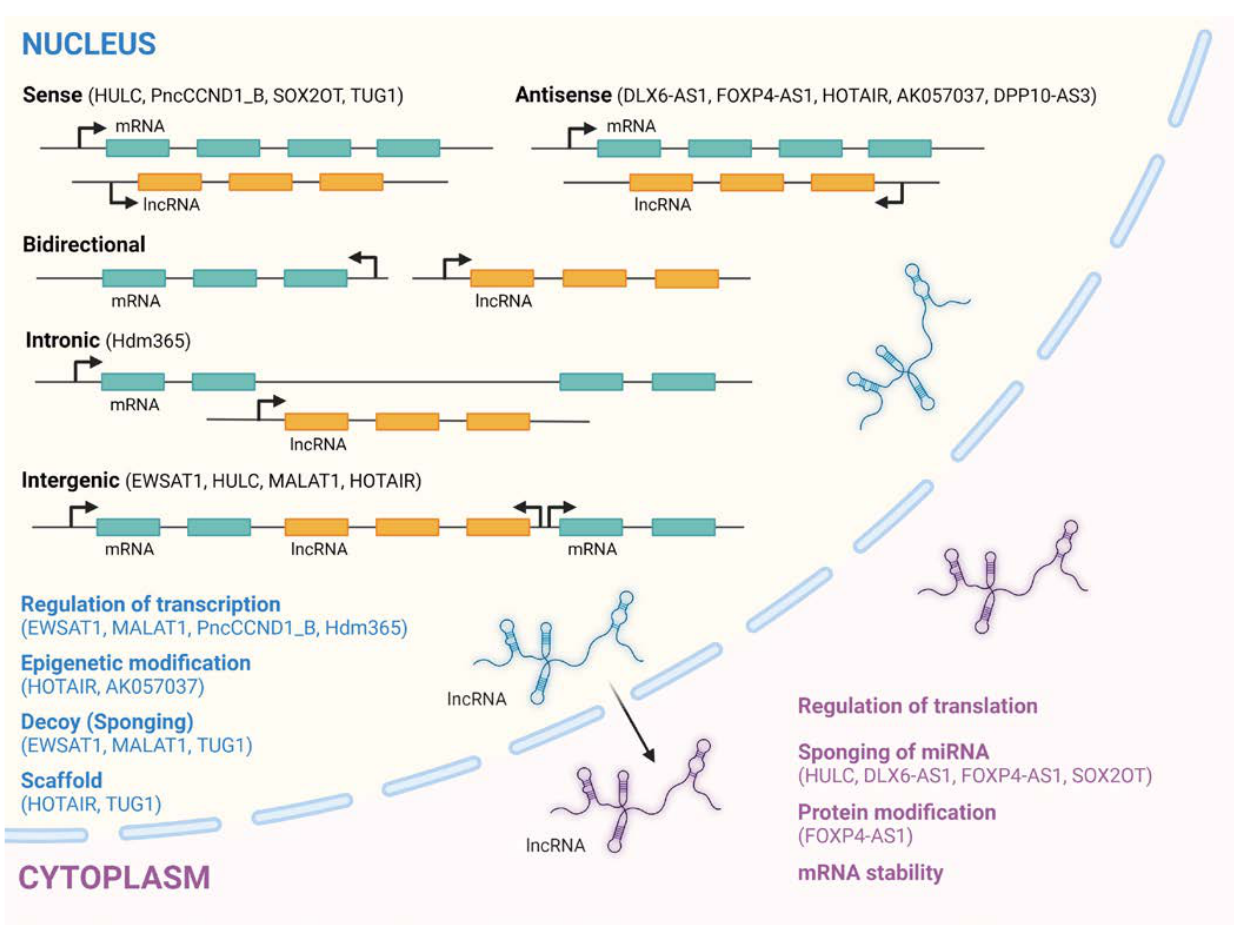
Figure 1. Classifications of lncRNAs and the genome locations where they are transcribed relative to protein-coding genes within the cell. Cell compartmental distribution of lncRNAs and their respective functions as well as ES-associated ones (in brackets) are indicated. Figure created with Biorender.com (accessed on 26 February 2022).